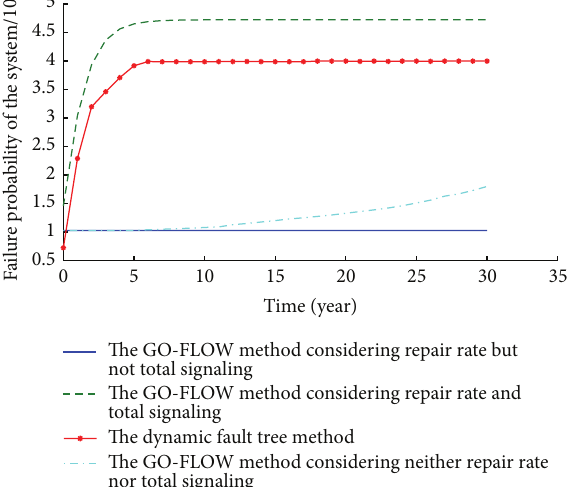
Figure 9: The failure probability’s changing trend of NPP’s power supply